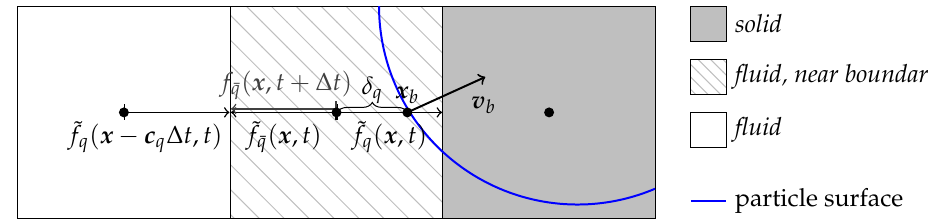
Figure 3. Sketch of the particle-mapping and the boundary treatment according to the CLI boundary scheme from Equation